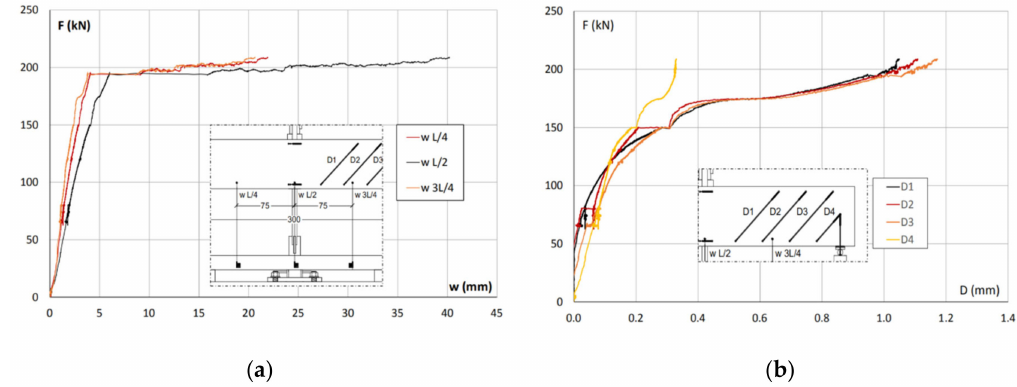
Figure 12. ( a ) Force–displacement, given by three vertical transducers applied at L / 4, L / 2 and 3L / 4; ( b ) force–diagonal displacement, given by the four diagonal